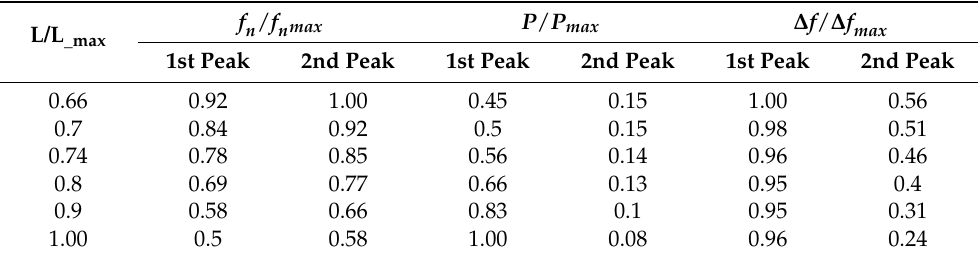
Table A7. The influence of the normalized bimorph length on the normalized output harvested power—two bimorphs interconnected by a spring case.